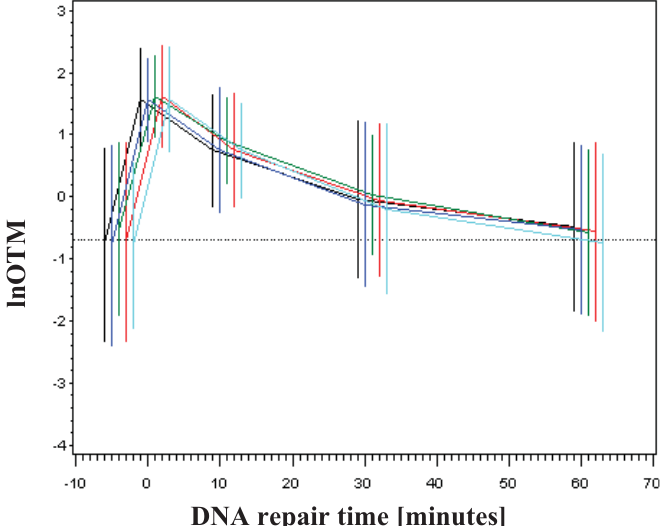
Figure 1. Time kinetic of DNA damage and repair by groups of relatives (mean and ± std. dev.)